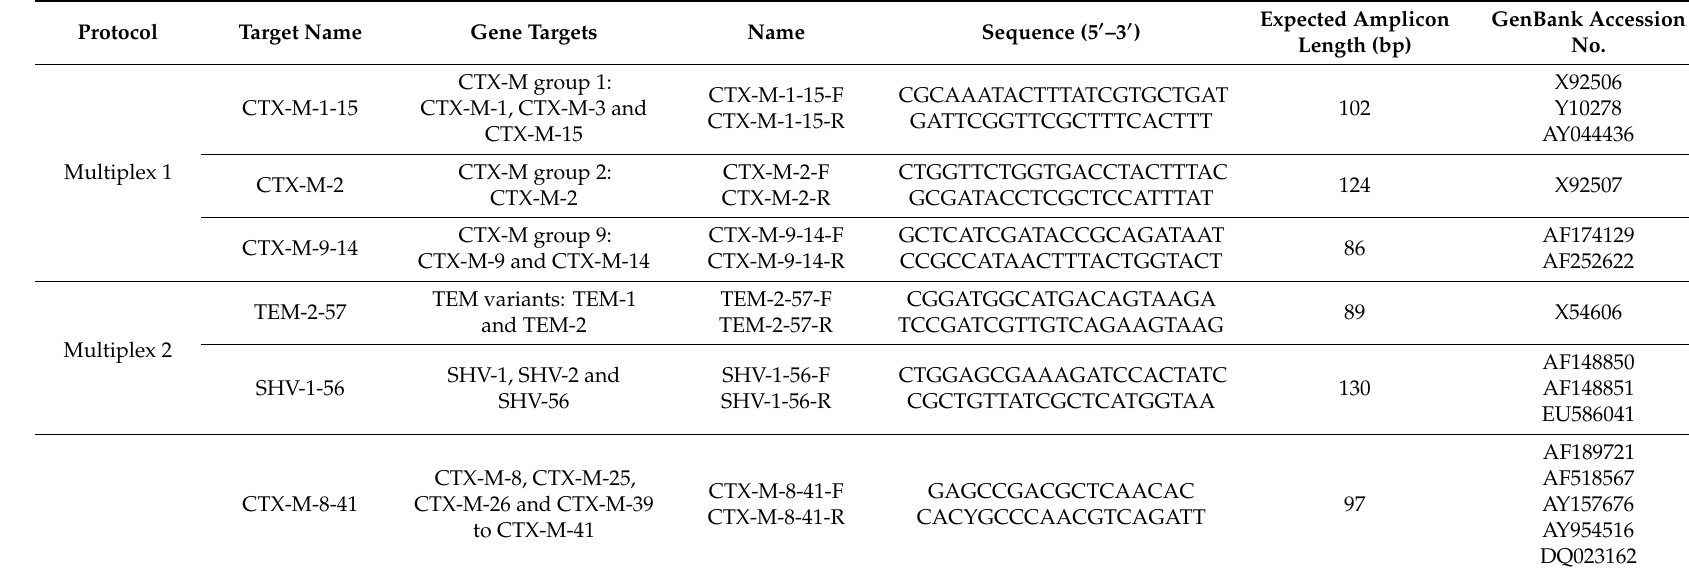
Table 1. Primers used in this